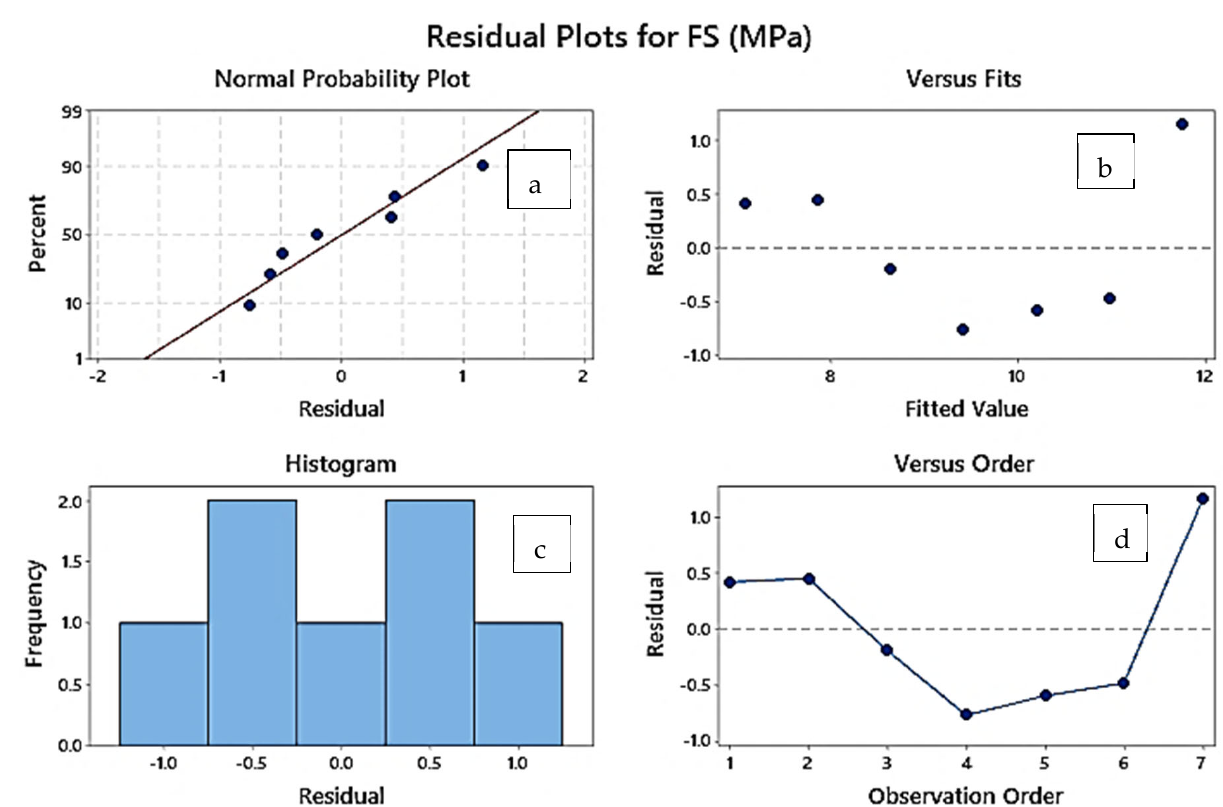
Figure 7. Residual plot for TAT samples based on a linear regression model. ( a ) Normal probability plot. ( b ) Fit vs. residual plot. ( c ) Frequency vs. residual plot. ( d ) Residual vs. observation order plot.